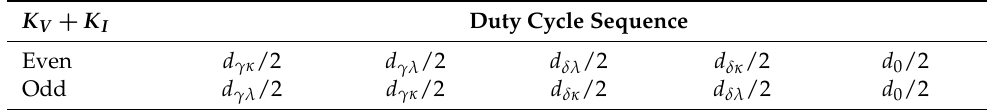
Table 6. Duty cycle patterns of the conventional SVM (CSVM) for the first half of T s . K V + K